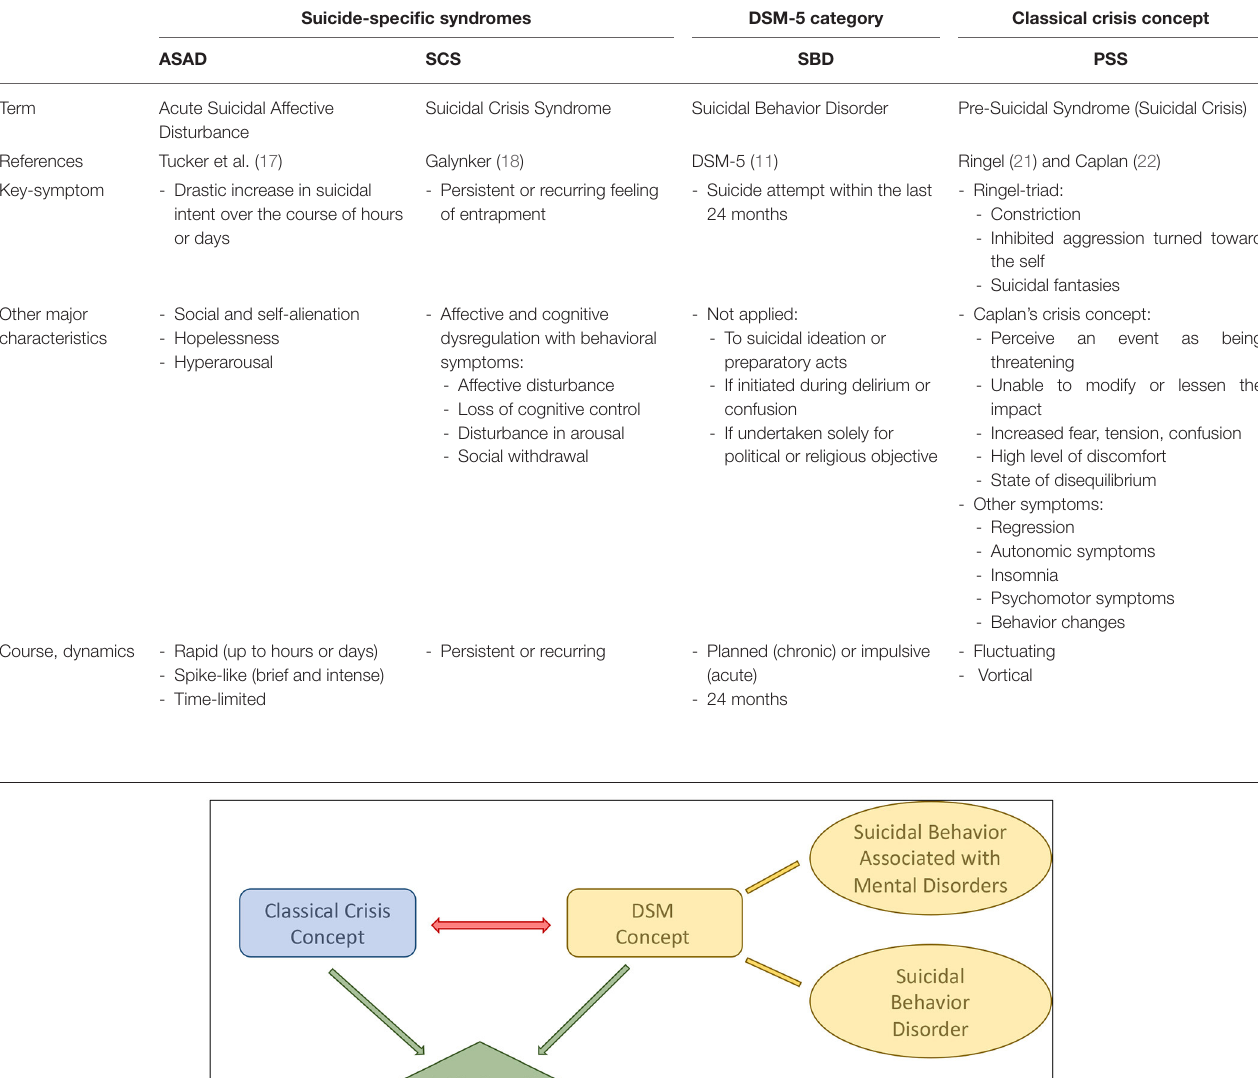
TABLE 3 | Comparison of the newly described suicide-specific syndromes [acute suicidal affective disturbance (ASAD) and suicidal crisis syndrome (SCS)] with suicidal behavior disorder (SBD) included in DSM-5 and with the classical suicidal crisis concept.